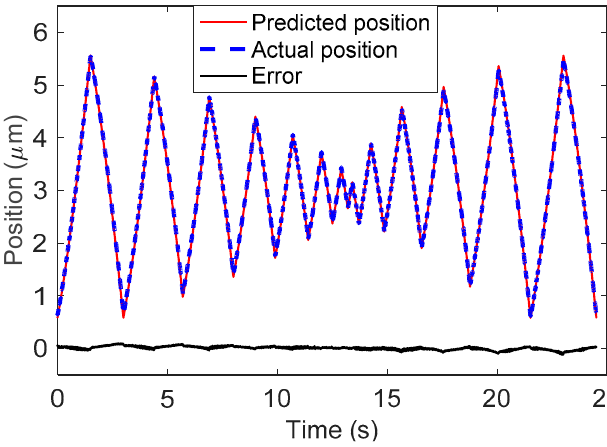
Figure 13. Position prediction results.